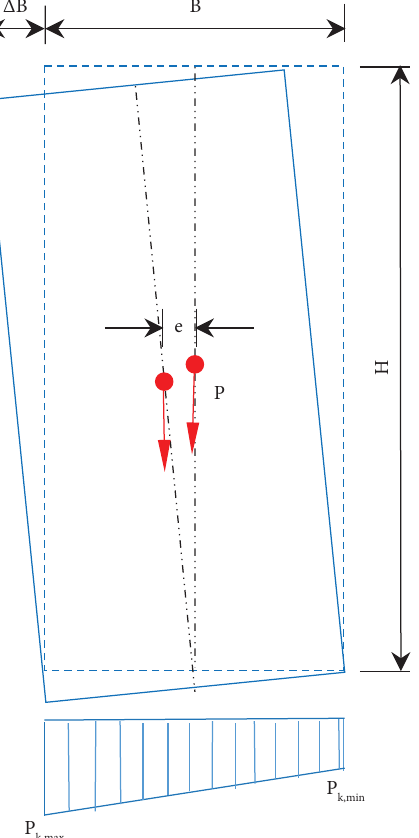
Figure 1: Analysis sketch for redistribution of contact